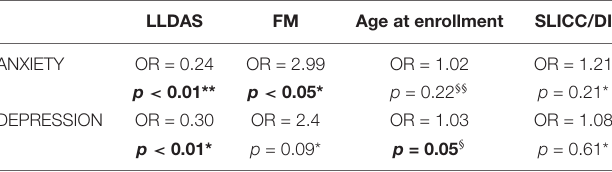
TABLE 2 | Determinants of mood disorders: Results of the multivariate analysis.